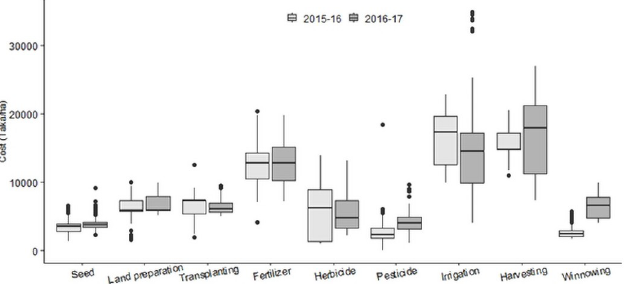
Fig 2. Variation of site-averaged total paid-out costs of different inputs: Seed (including seed, nursery preparation and seedling development), land preparation (tillage), transplanting (including seedling uprooting), fertilizer, herbicide (including weeding), pesticide, irrigation, harvesting (crop cutting, carrying, and threshing), winnowing (including drying) for Boro rice cultivation in 2015–16 and 2016–17. Boxes have horizontal bounds from first quartile (Q1) to third quartile (Q3). The horizontal line at the middle of the boxes represent the median. The dots represent the outliers in the